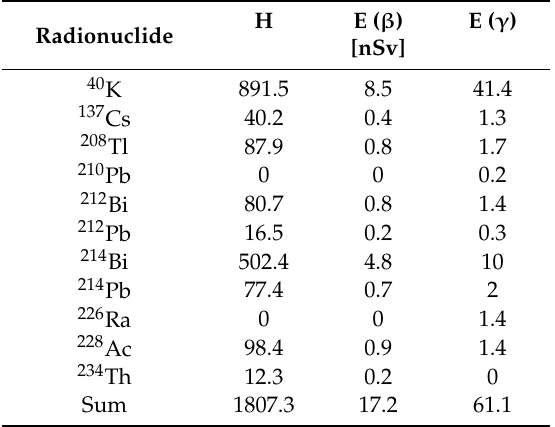
Table 2. The equivalent H dose and the effective E dose obtained during a series of 15 mud bath treatment applications to the skin by beta and gamma radiation during half-hour exposures.